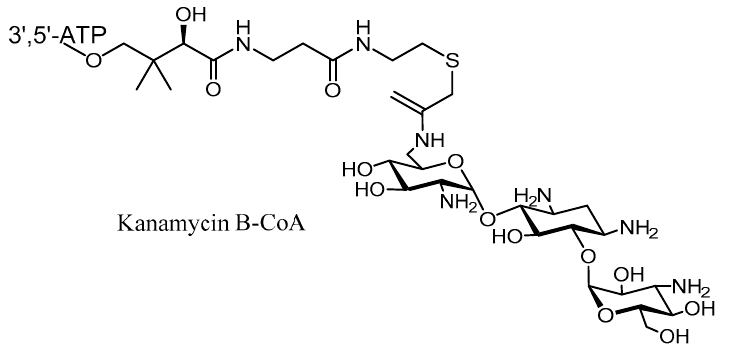
Figure 10. Structure of Kanamycin –CoA inhibitor to AME.